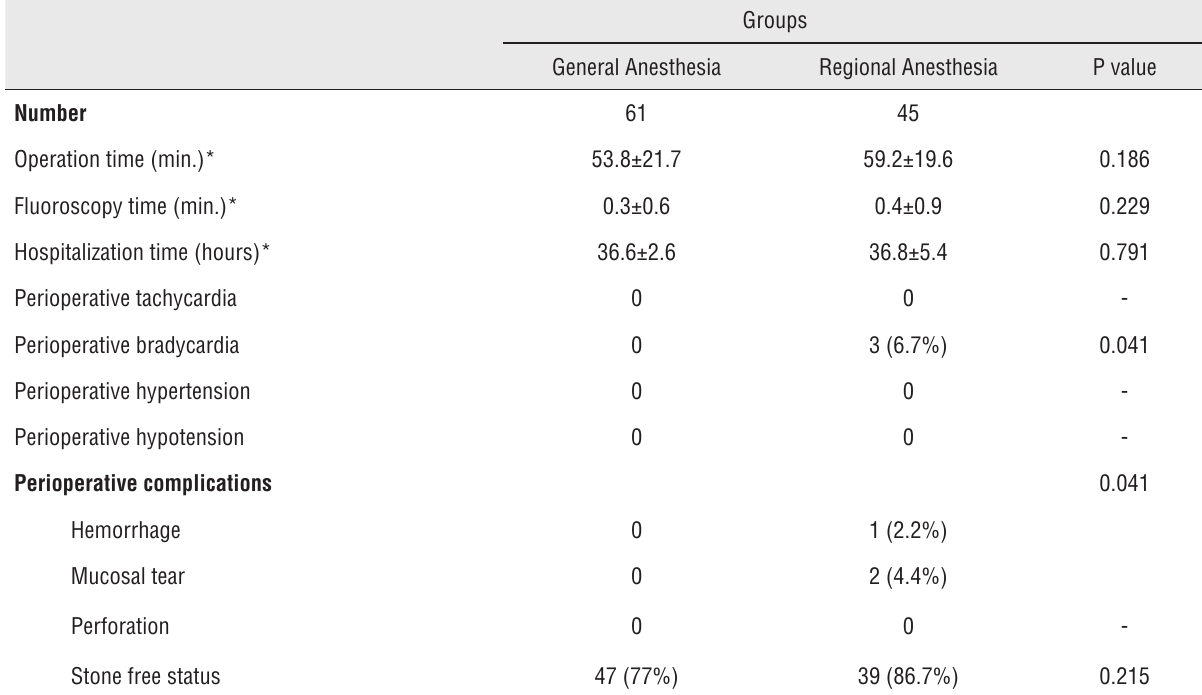
Table 2 - Comparison of perioperative parameters and outcomes.